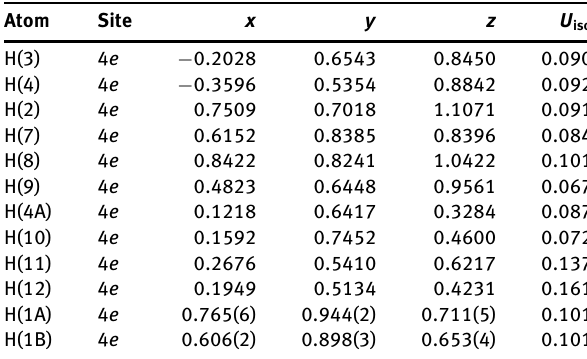
details of the measurement method and a list of the atoms including atomic coordinates and displacement parameters.